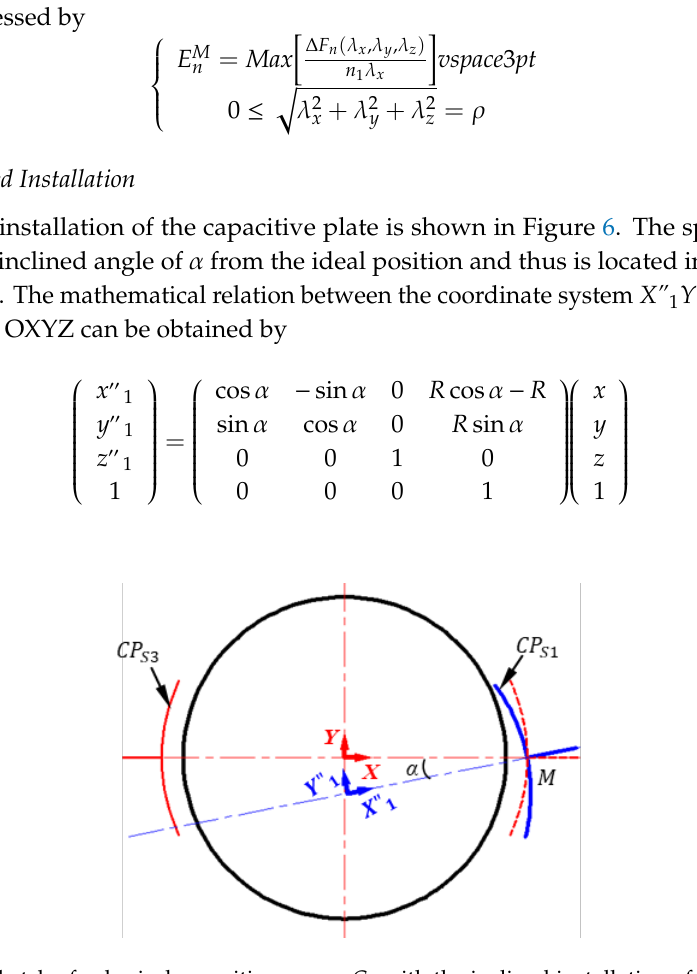
x with the inclined installation of the plate CP S 1